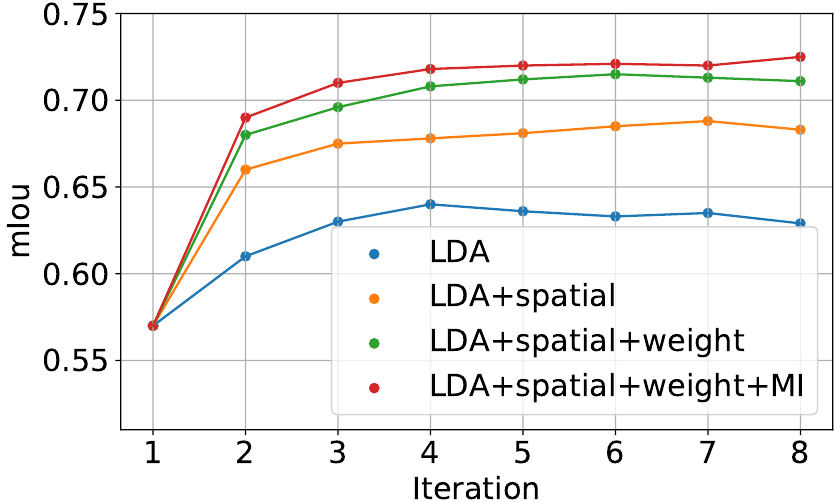
Figure 8. Performance on coral images test dataset with different component of proposed method.